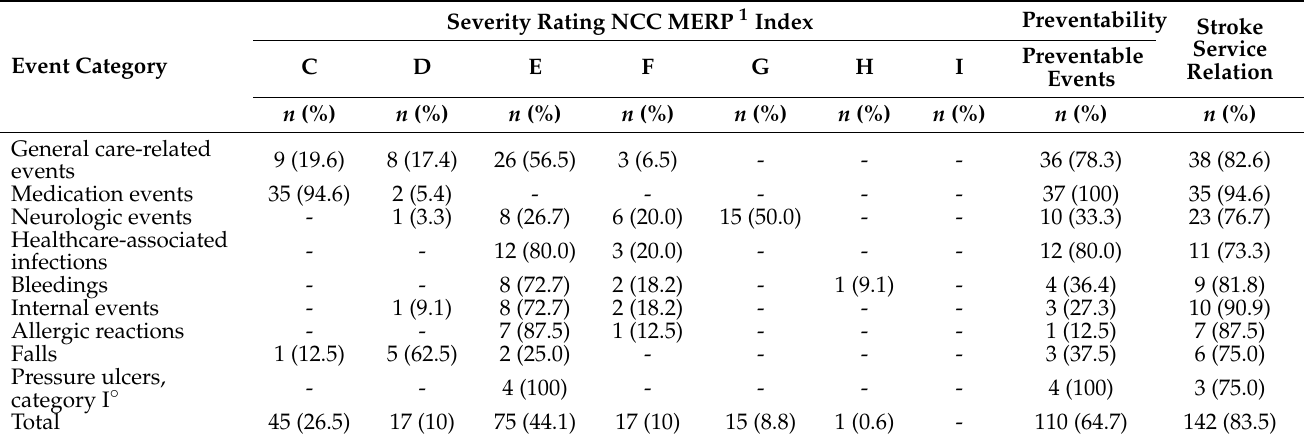
Table 4. Severity rating, preventability, and relation to stroke